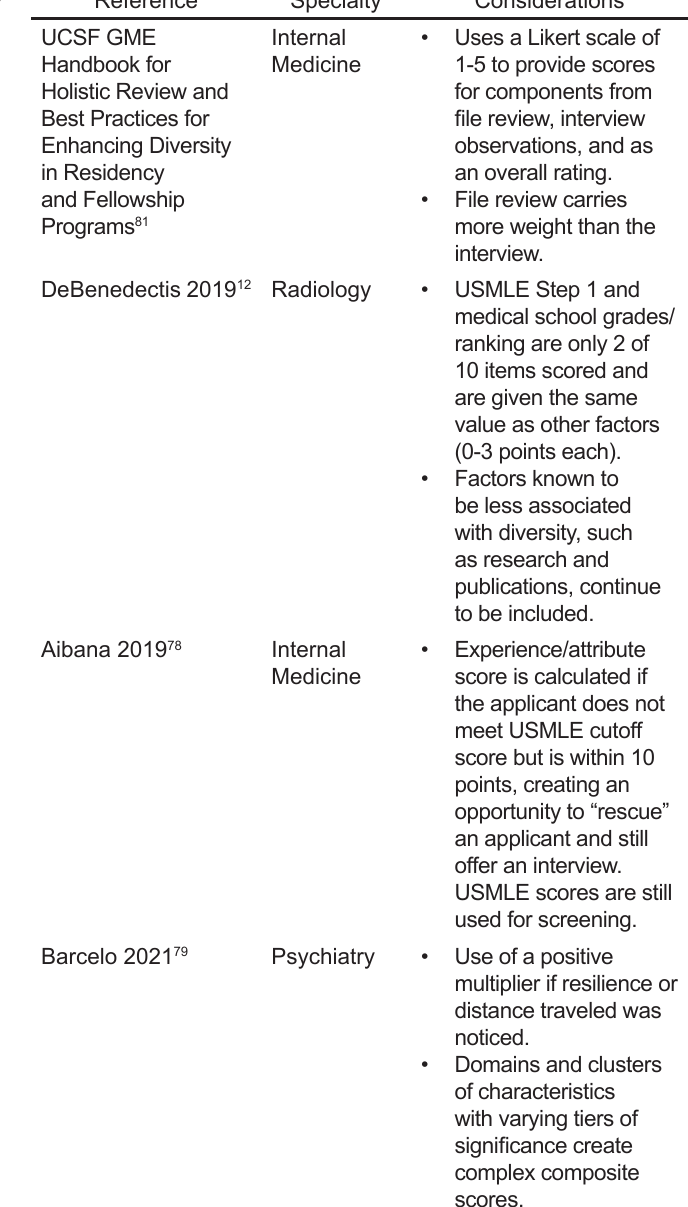
Table 3. Example scoring rubrics incorporating holistic review